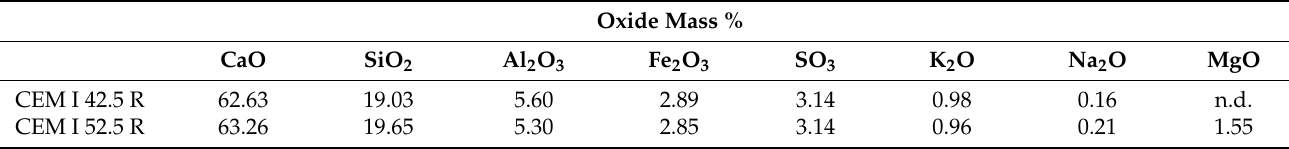
Table 2. Chemical composition of CEM I 42.5 R and CEM I 52.5 R